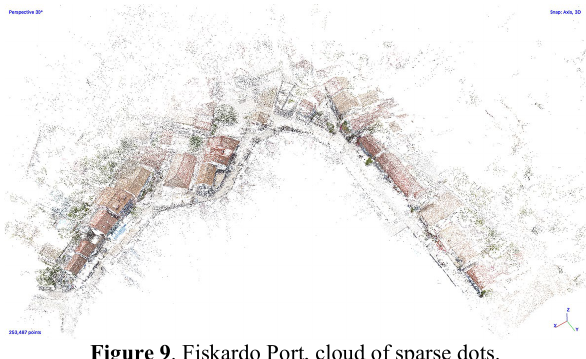
Figure 9 . Fiskardo Port, cloud of sparse dots.